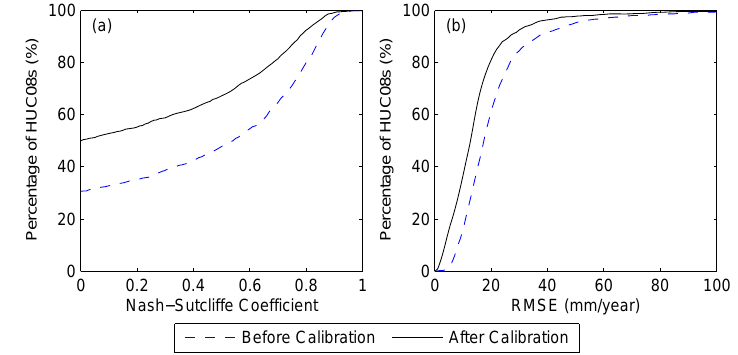
Fig. 14. Model performance before and after calibration, showing